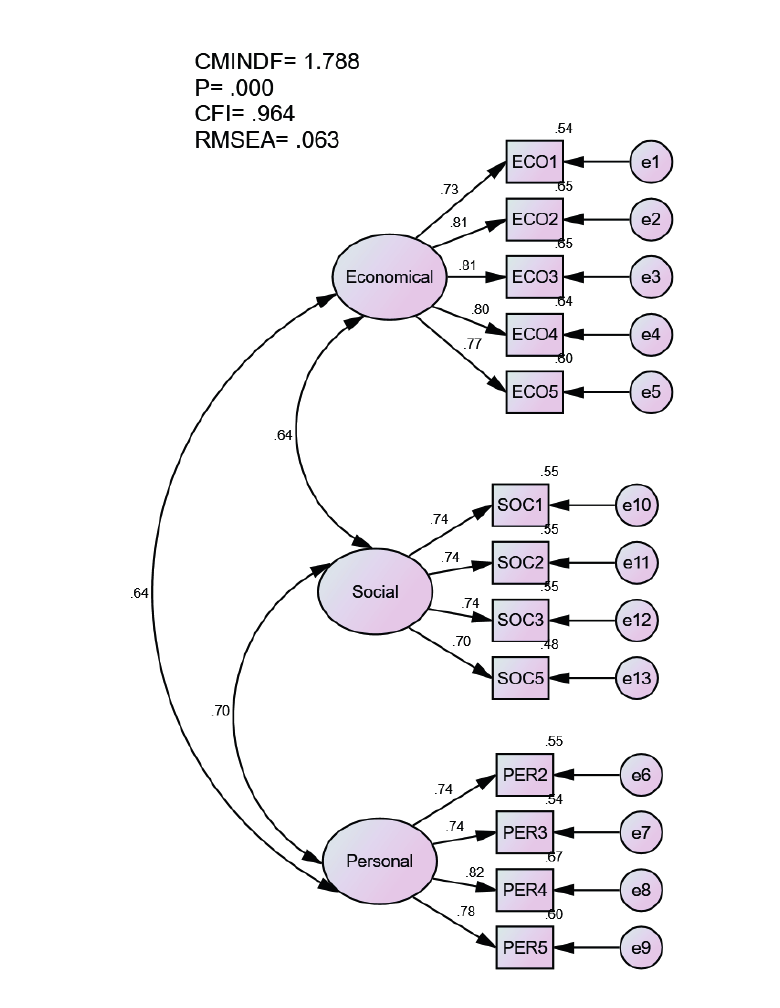
Fig. 2. Confirmatory factor